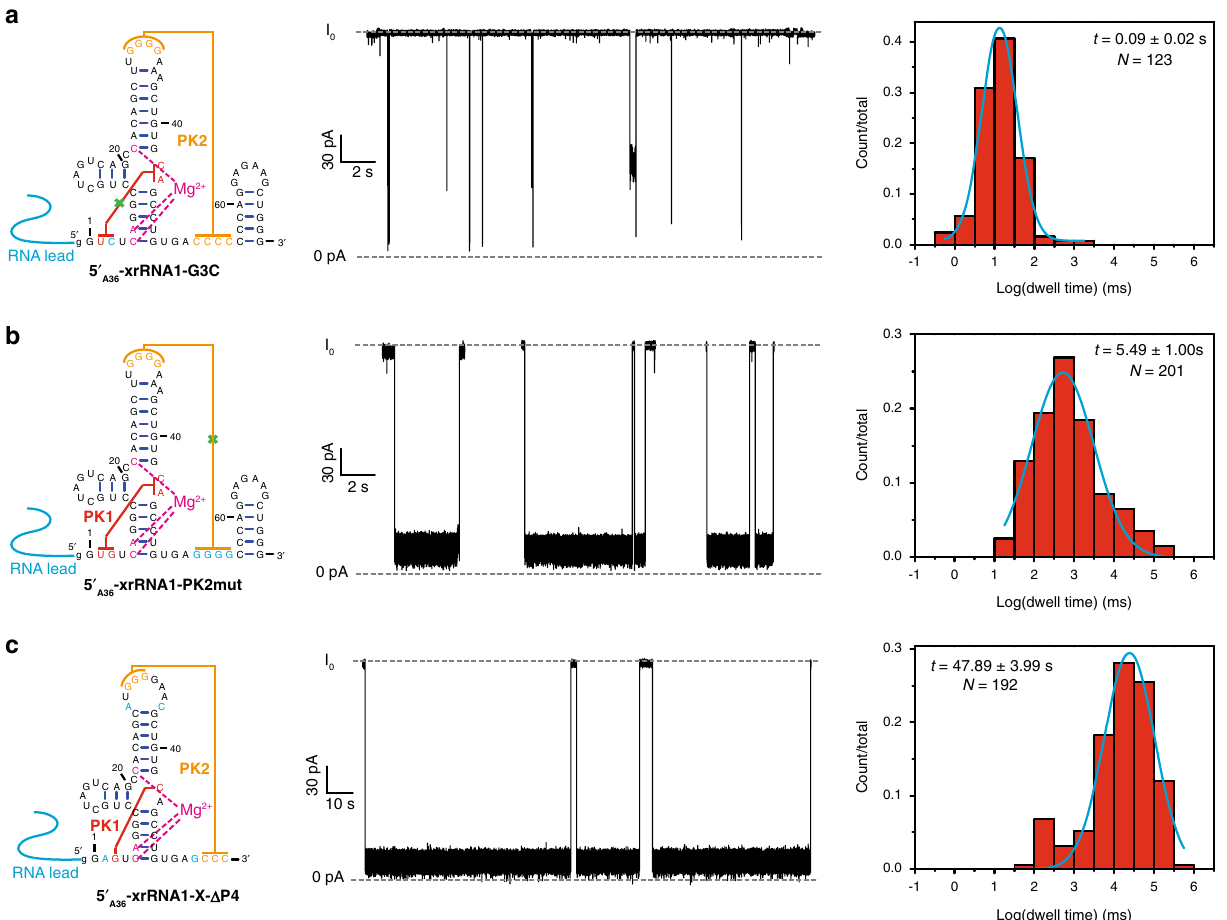
Fig. 4 Contributions of key tertiary interactions to the directional mechanical stability of ZIKV xrRNA1. a – c Secondary structures (left), representative current blockade traces (middle), and the respective dwell time histogram (right) for the directional mechanical unfolding of 5 ′ A36 -xrRNA1-G3C ( a ), 5 ′ A36 - xrRNA1-PK2mut ( b ), and 5 ′ A36 -xrRNA1-X- Δ P4( c ) in the α -HL